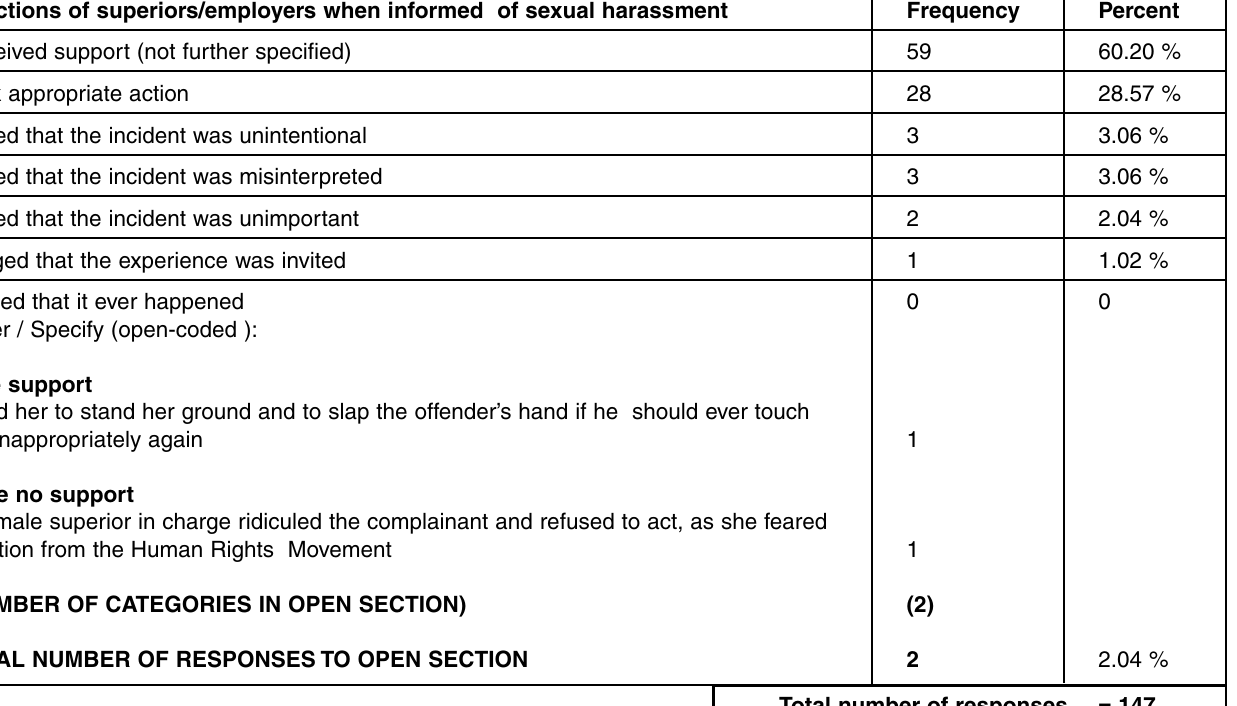
Table 3: Reactions from superiors / employers when informed of the sexual harassment Reactions of superiors/employers when informed of sexual harassment